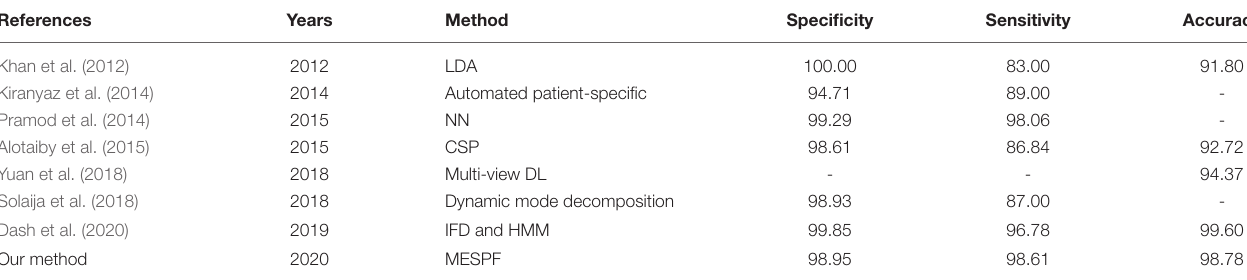
TABLE 2 | In classification tasks of pre-ictal and inter-ictal, the framework is compared with other advanced